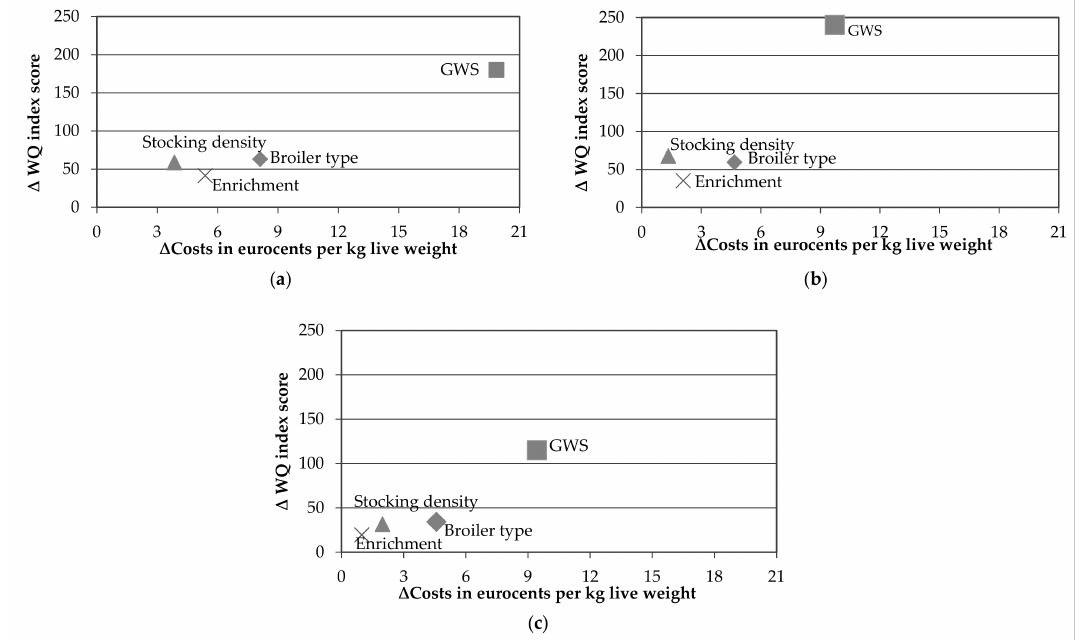
Figure 3. Cost-e ffi ciency of implementing three single measures in the conventional production system in ( a ) the Netherlands ( b ) United States ( c )